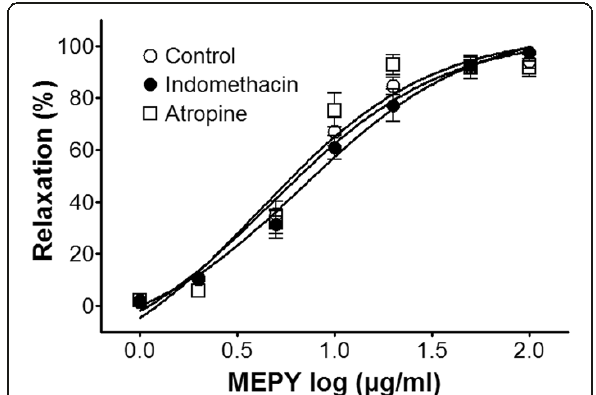
Figure 3 Relaxation responses induced by MEPY in endothelium-intact rat aortic rings pre-contracted with phenylephrine (PE, 1 μ M) in the presence or absence